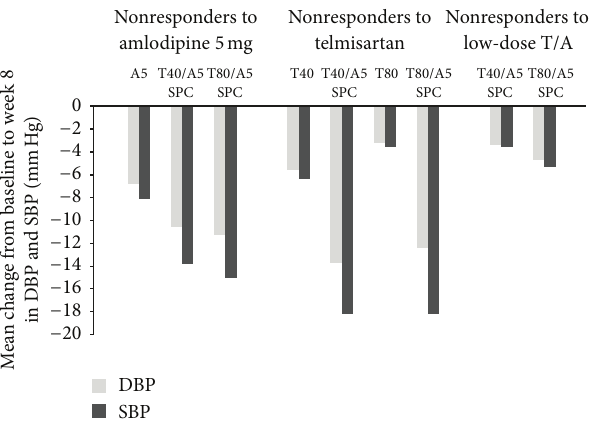
Figure 1: Change from baseline in DBP and SBP in the three groups after 8 weeks’ treatment with T/A combination. Baseline indicates reference baseline BP value, which was measured imme- diately before first dosing in the double-blind treatment period. A5: amlodipine 5 mg; BP: blood pressure; DBP: diastolic blood pressure; SBP: systolic blood pressure; SPC: single-pill combination; T/A: telmisartan/amlodipine; T40: telmisartan 40 mg; T80: telmisartan 80